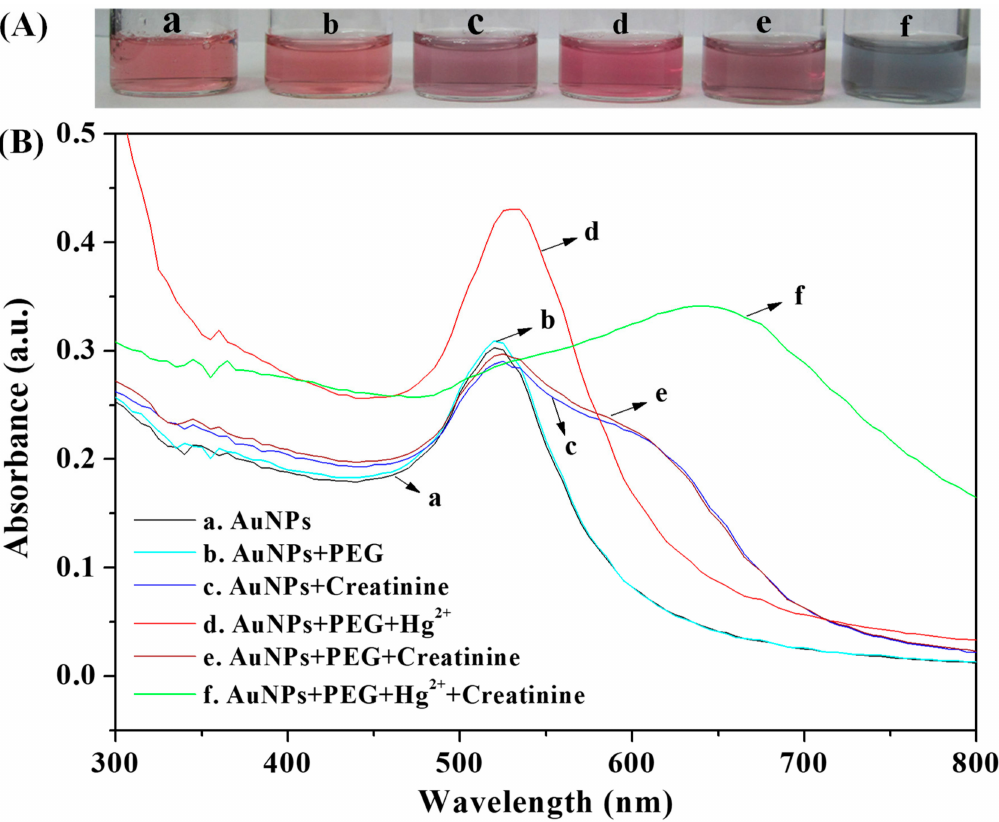
Figure 1. ( A ) Photographs and ( B ) UV–Vis absorption spectra of (a) 1.12 nM AuNPs; (b) 1.12 nM AuNPs with 1.0 mM PEG; (c) 1.12 nM AuNPs with 50 µ M creatinine; (d) 1.12 nM AuNPs with 1.0 mM PEG and 0.1 mM Hg 2 + ; (e) 1.12 nM AuNPs with 1.0 mM PEG and 50 µ M creatinine; (f) 1.12 nM AuNPs with 1.0 mM PEG 0.1 mM Hg 2 + and 50 µ M